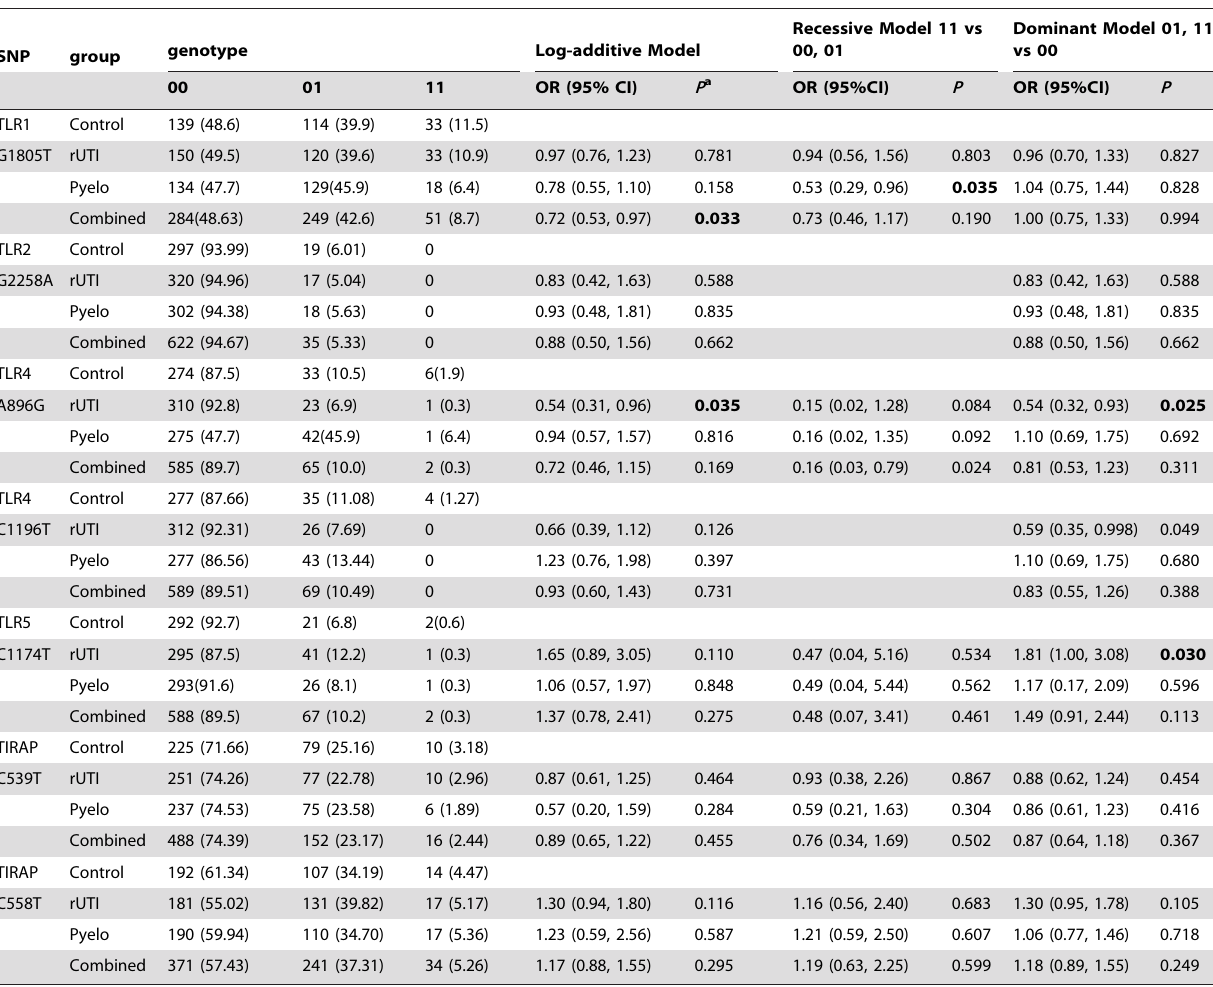
Table 2. Genotypic Analysis of Functional TLR SNPs in Caucasian